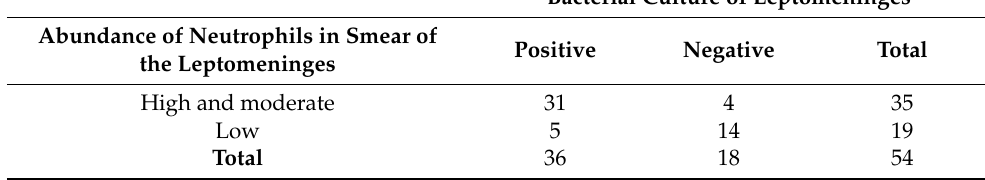
Table 3. Abundance of neutrophils (high–moderate versus low) in a cytological smear in relation to the bacterial culture of the leptomeninges (either positive or negative) *. Bacterial Culture of Leptomeninges Abundance of Neutrophils in Smear of the Leptomeninges